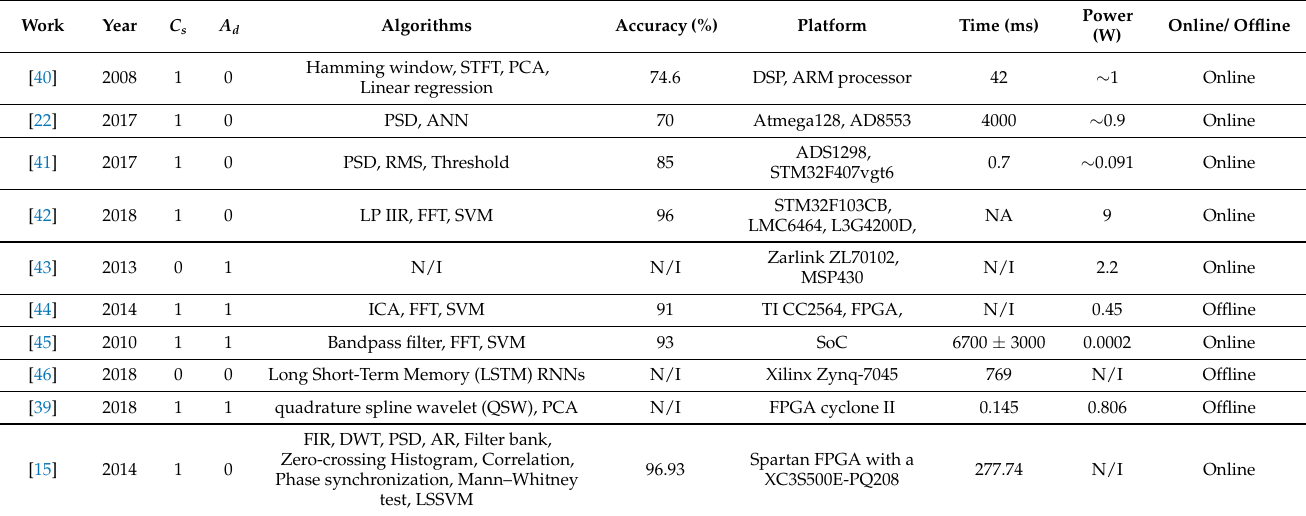
Table 2. Summary of related works on embedded BCIs for pathological disorders: N/I: No indication, 0: bad, 1:good.